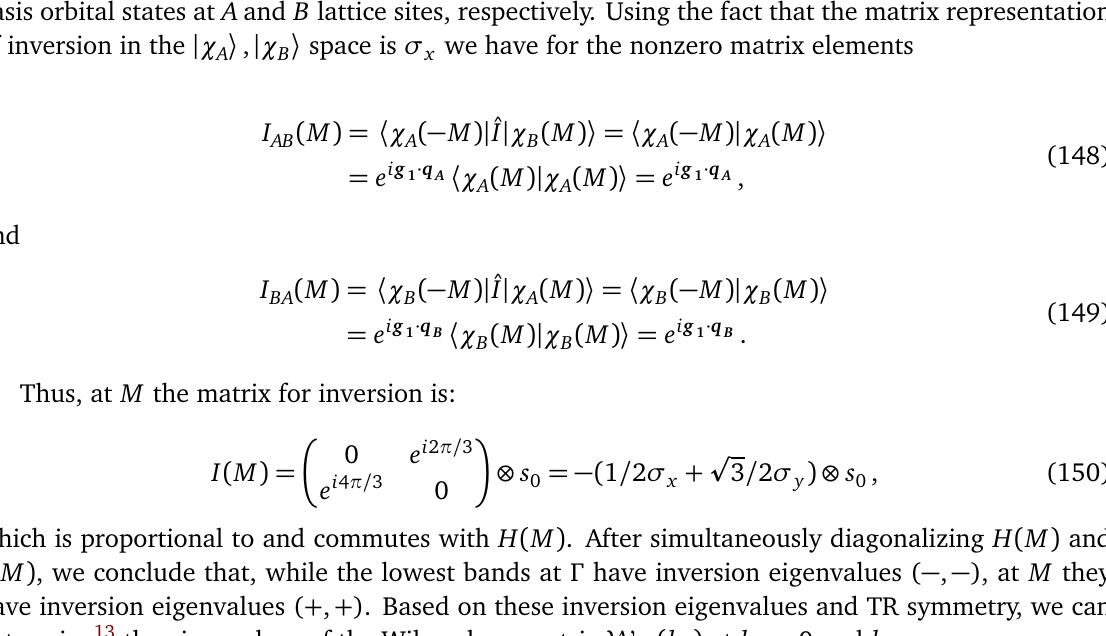
Figure 14: (a) Bands corresponding to the Hamitonian in Eq. (144), with the char- acteristic Dirac cone at K. (b) Eigenvalues of W the term H from Eq. SO